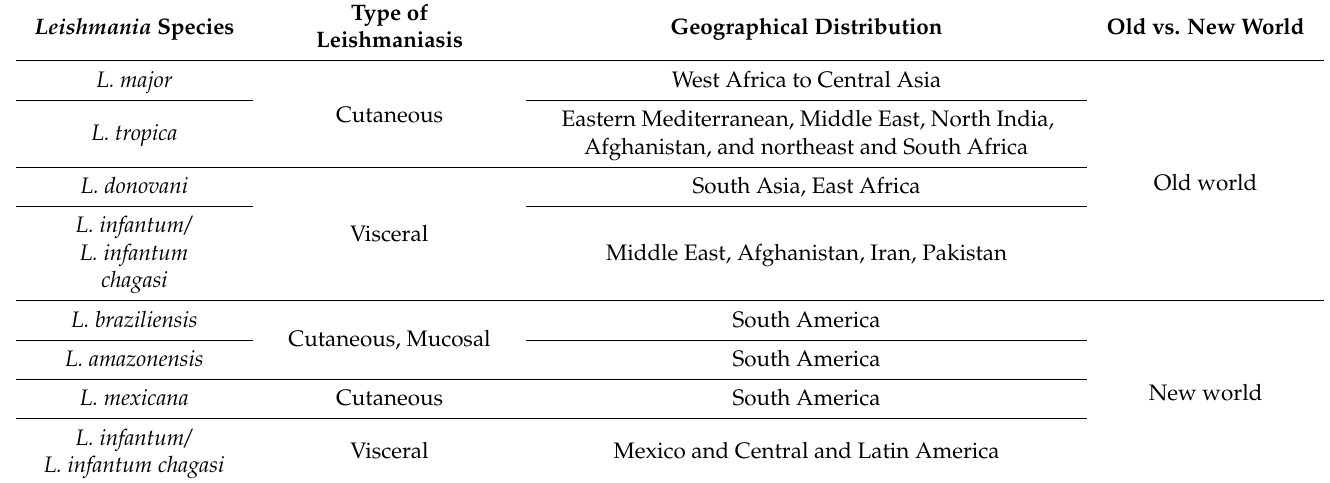
Table 1. Relevant Leishmania